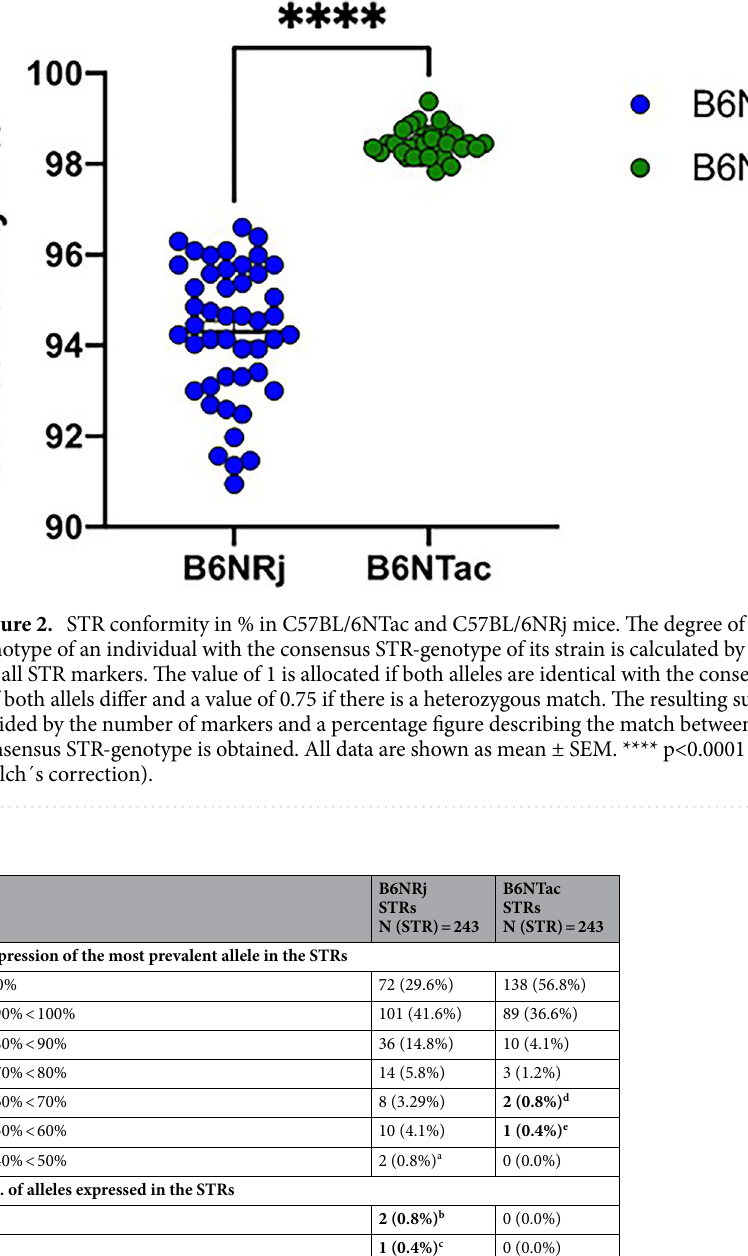
Table 1. Expression of the most prevalent allele and no of alleles expressed in standard tandem repeats (STRs) of B6NRj and B6NTac mice. STRs written in bold were selected as factors for incorporation in a two-way ANOVA for evaluation of the effect of liraglutide in a model of diet-induced obesity. a D11S112, D15S215; b D12S206, D9S312; c D16S147; d D1S113, D9S218; e DXS312. Significant values are in bold.